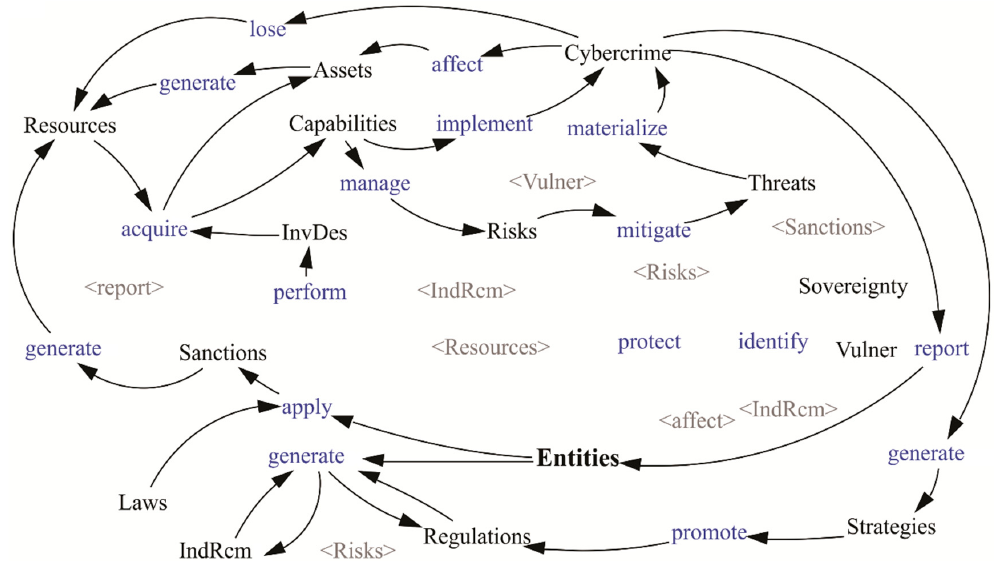
Figure 8. Cycle of crimes by strategies, laws, and sanctions with the participation of assets.